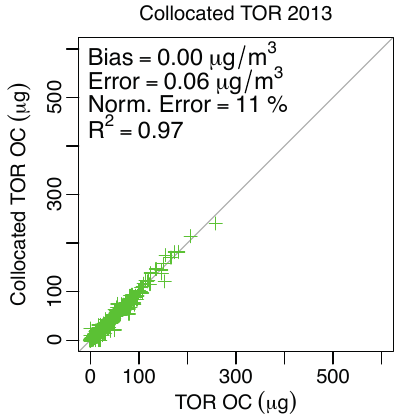
Figure 3. Scatter plot and performance metrics between the mea- surements of the collocated TOR OC. Concentration units of µgm − 3 for bias and error are based on the IMPROVE nominal vol- ume of 32.8m 3